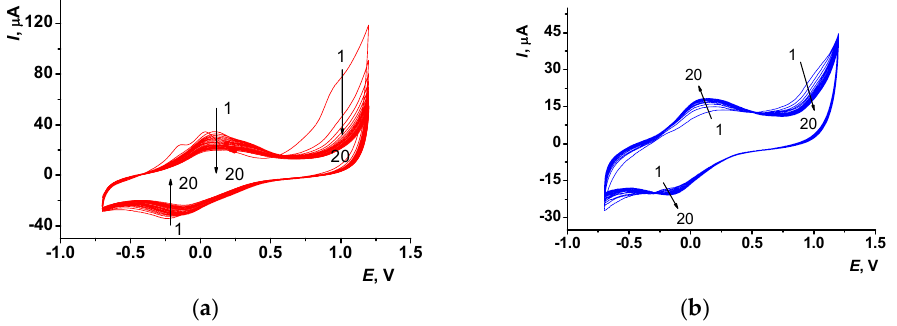
Figure 2. Cyclic voltammograms recorded on GCE modified with ( a ) Azure A in the CB suspension and ( b ) Azure A in fMWCNTs suspension in 0.1 M phosphate buffer containing 0.1 M NaNO 3 , pH 7.0, scan rate 100 mV/s, 20 cycles (odd cycles are shown) arrows indicate changes with increased cycle number.